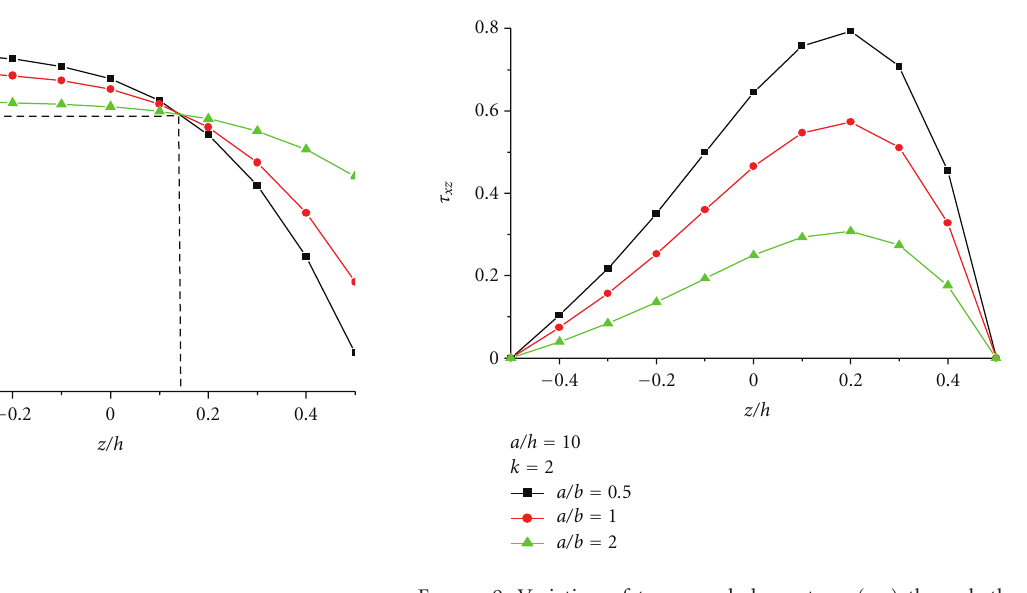
Figure 7: Variation of longitudinal tangential stress ( τ xy ) through- the thickness of an FGM plate for di ff erent values of the aspect ratio.